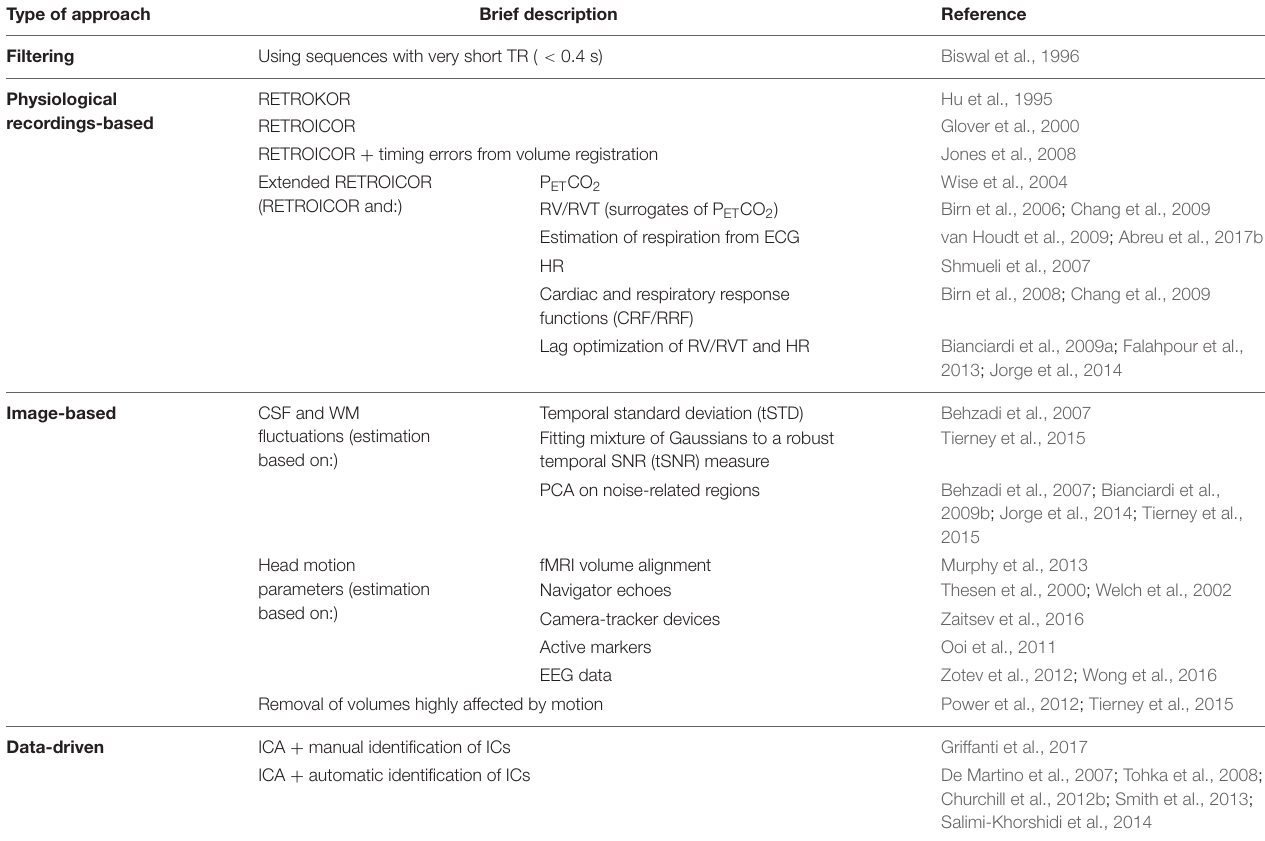
TABLE 3 | List of BOLD-fMRI physiological noise correction methods. These methods can be roughly divided into four main approaches: filtering, physiological recordings-based, image-based and